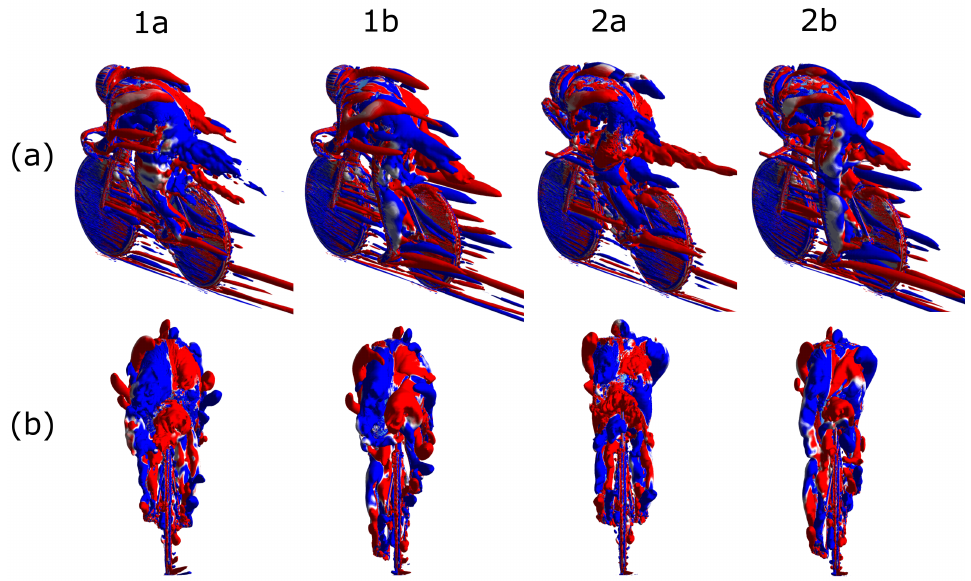
Figure 7. The dominant time-mean vortical flow structures around the rider visualised by the iso-surface of Q-criterion and coloured by the longitudinal vorticity ( ω x